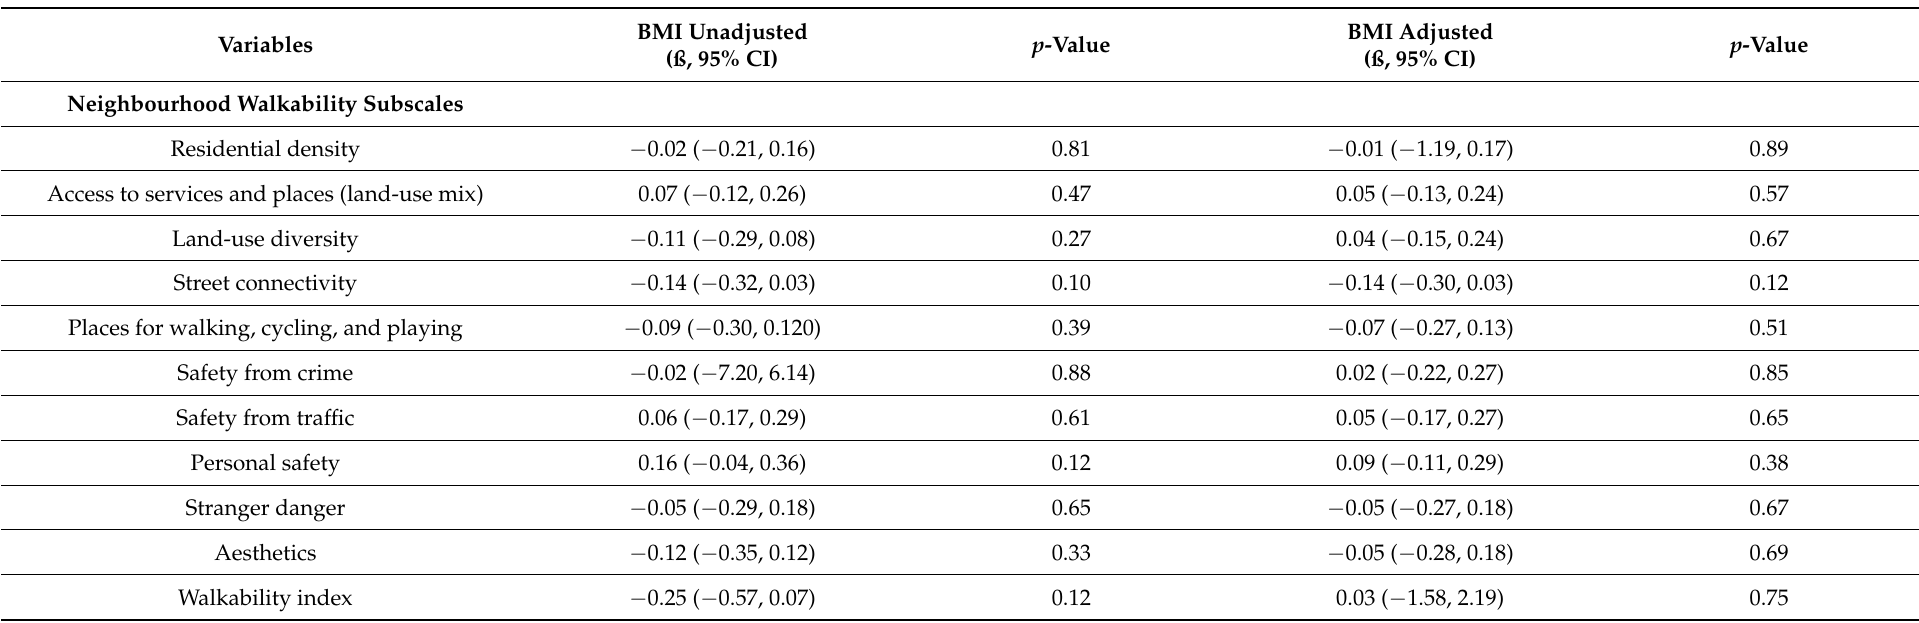
Table 5. Associations of perceived neighbourhood environmental attributes with body mass index of adolescents in urban South